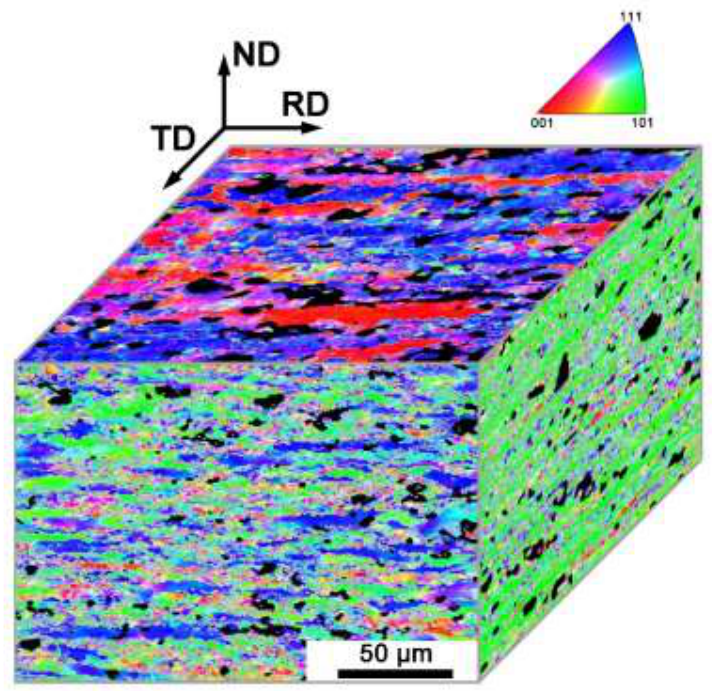
Figure 5. EBSD observation of preferentially corroded sites in the 90% cold-rolled samples after 30 days of immersion testing.